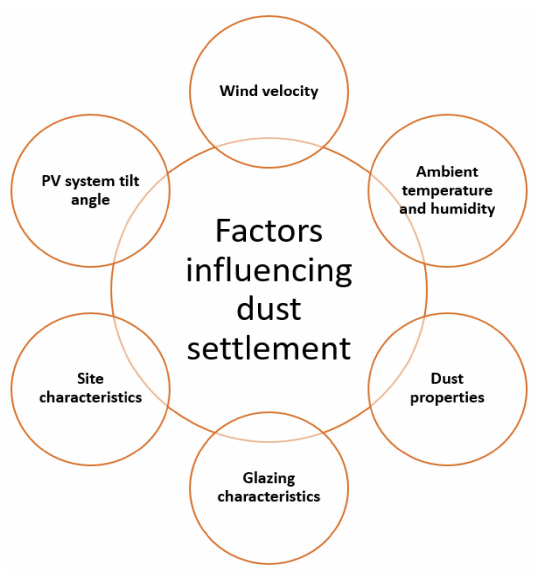
Figure 5. Factors influencing dust